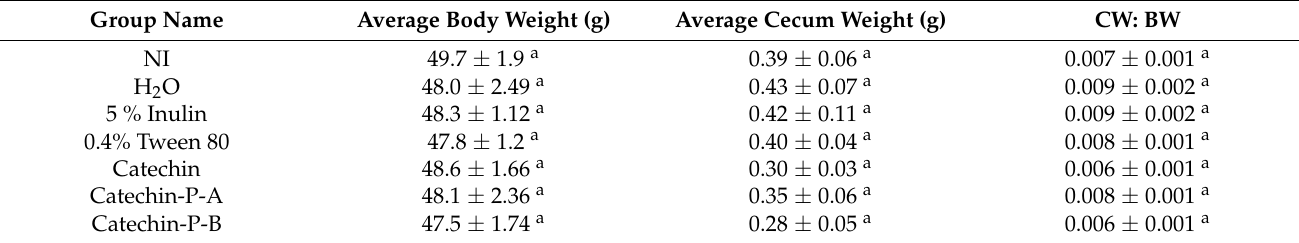
Table 1. Gross physiological parameters measured on the day of hatch 1 .